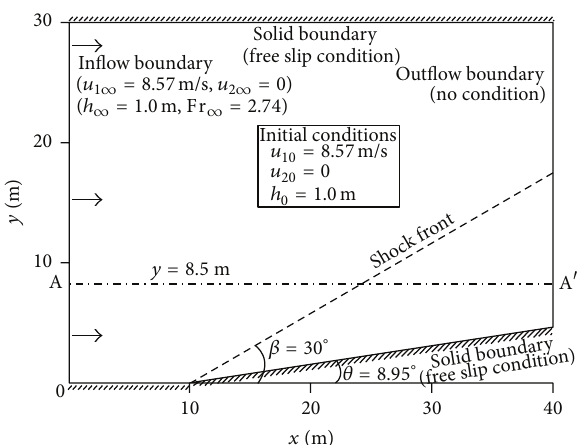
Figure 12: Schematic diagram and simulation conditions of oblique hydraulic jump problem in converging channel (plan view).